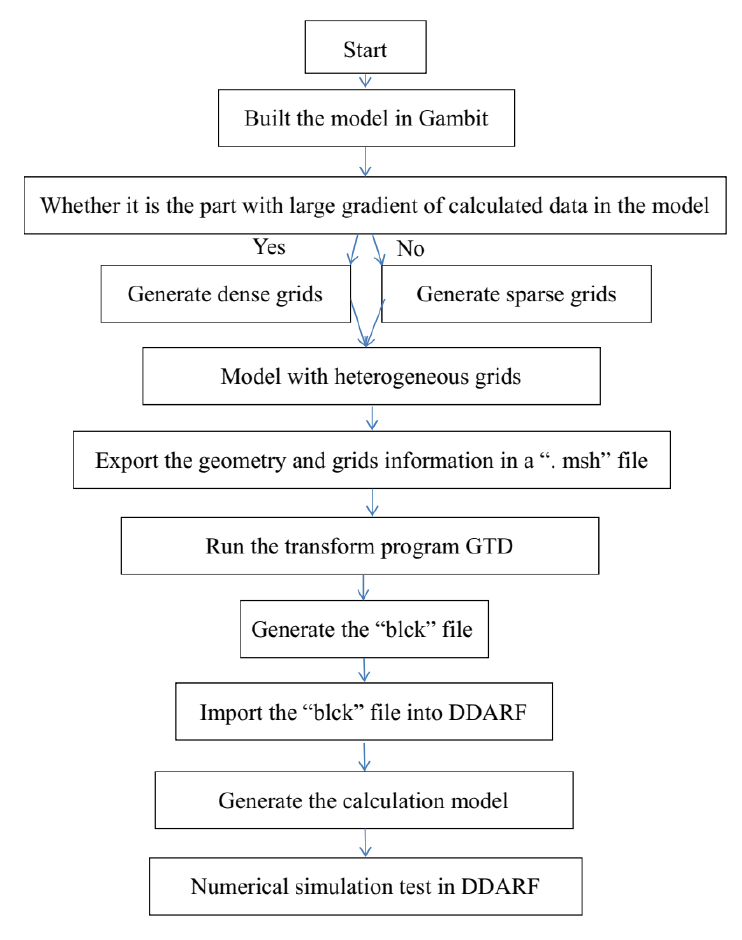
Figure 3. Technical flowchart of optimized DDARF generation of heterogeneous grids.